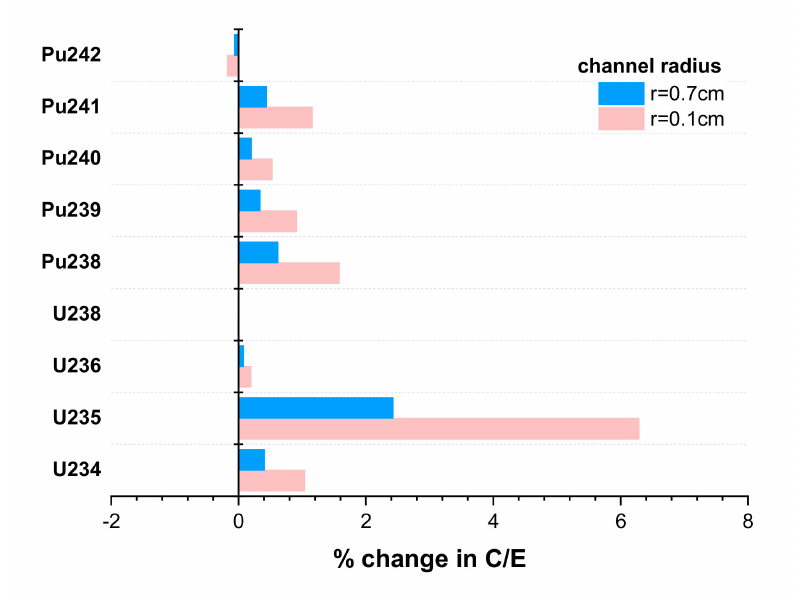
Figure 11. Change in U and Pu C/E isotope concentration ratios for different channel radii for corner rod sample